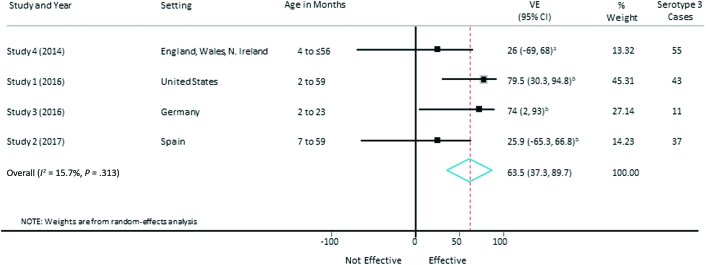
Vaccine effectiveness against serotype 3 invasive pneumococcal disease including only published studies with nonoverlapping datasets. Abbreviations: CI, confidence interval; VE, vaccine effectiveness. aVE for at least 2 doses before 12 months or 1 dose on or after 12 months. bVE for at least 1 dose.